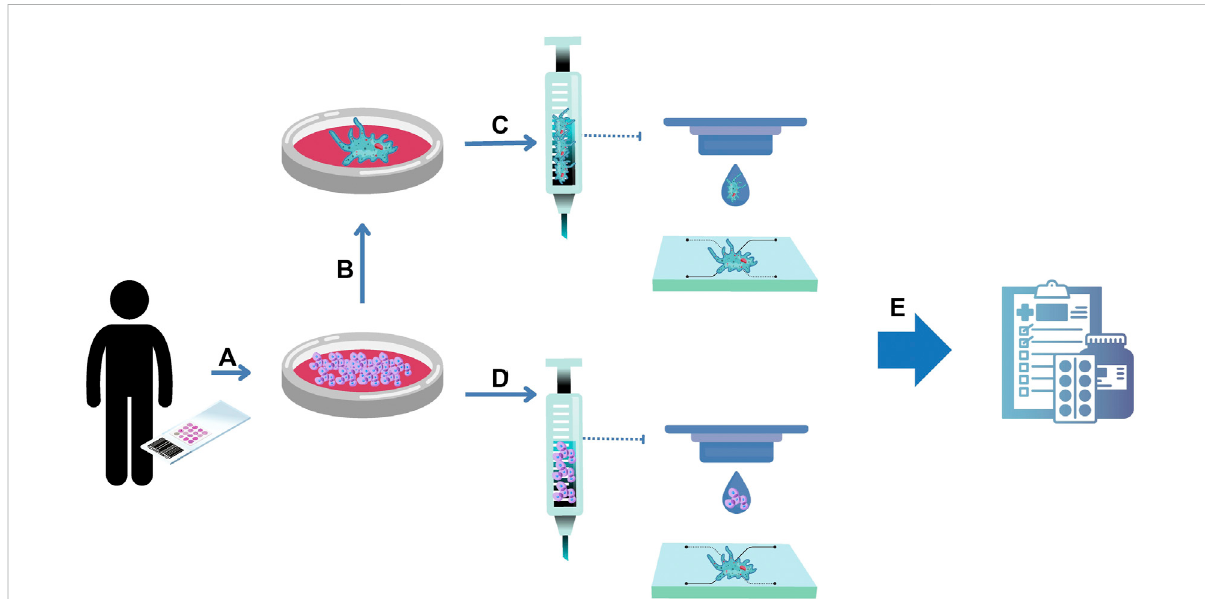
FIGURE 3 Organoids-on-a-chipfordrugdevelopment. (A) Humanprimarycellscanbeisolatedfromhealthyandunhealthytissuebiopsiesandexpanded in numbers. The resulting cells can be used to form organoids (B) . (C) Organoids can be embedded into hydrogels serving as a bioink for bioprinting protocols inside a chip. To provide scalability to the process, the resulting cells can be embedded into hydrogels serving as a bioink for